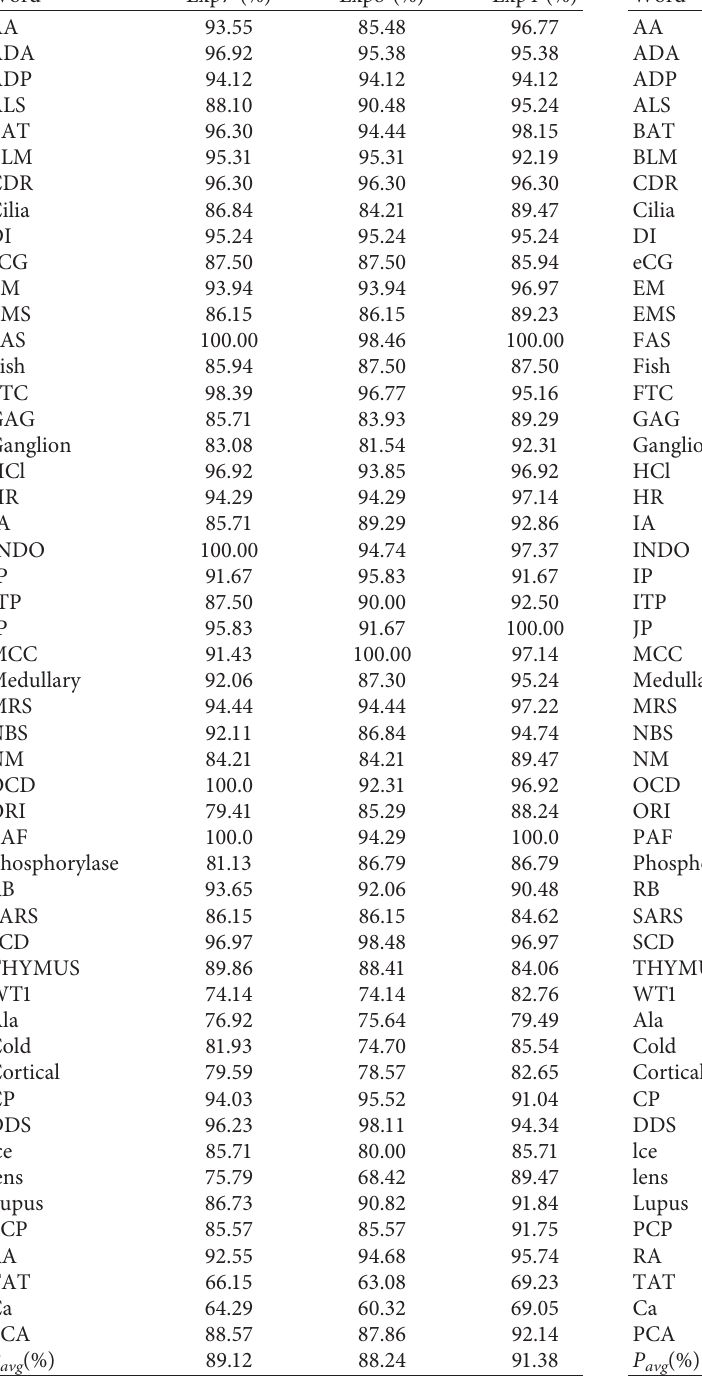
Table 4: Disambiguation accuracies of Experiment 4, Experiment 9, and Experiment 10.